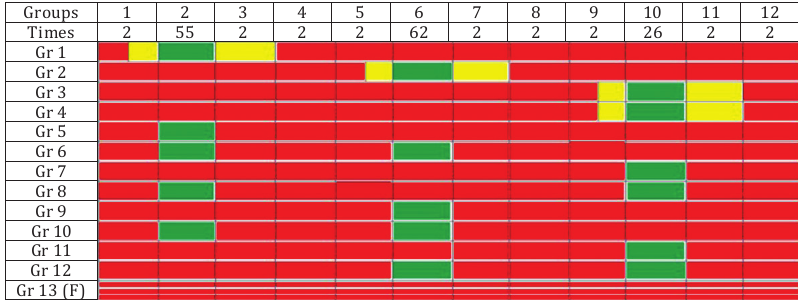
Figure 12. Software Output and intergreen times of roundabout in the current status